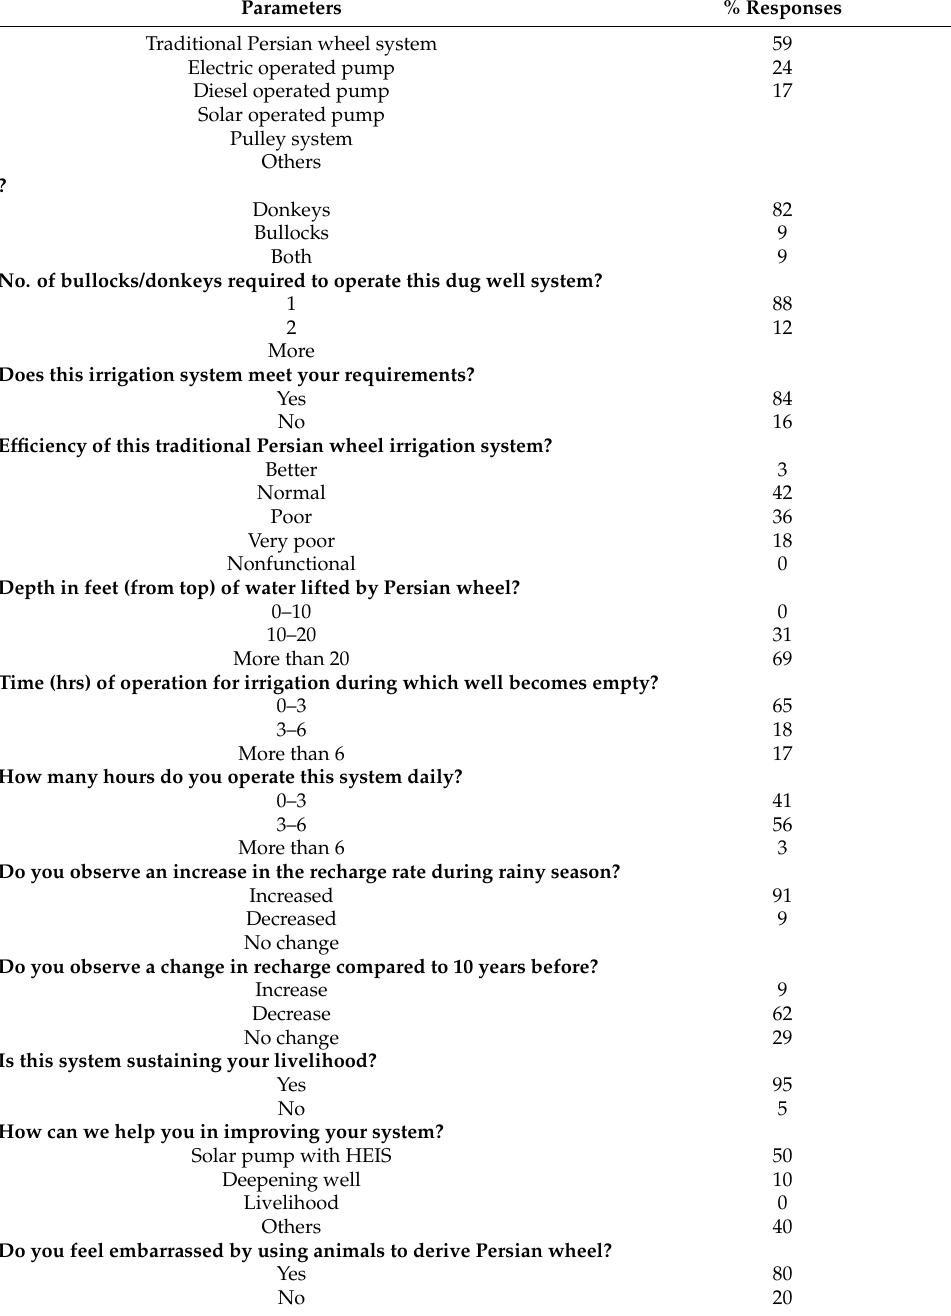
Table 5. Water-lifting system for dug well.